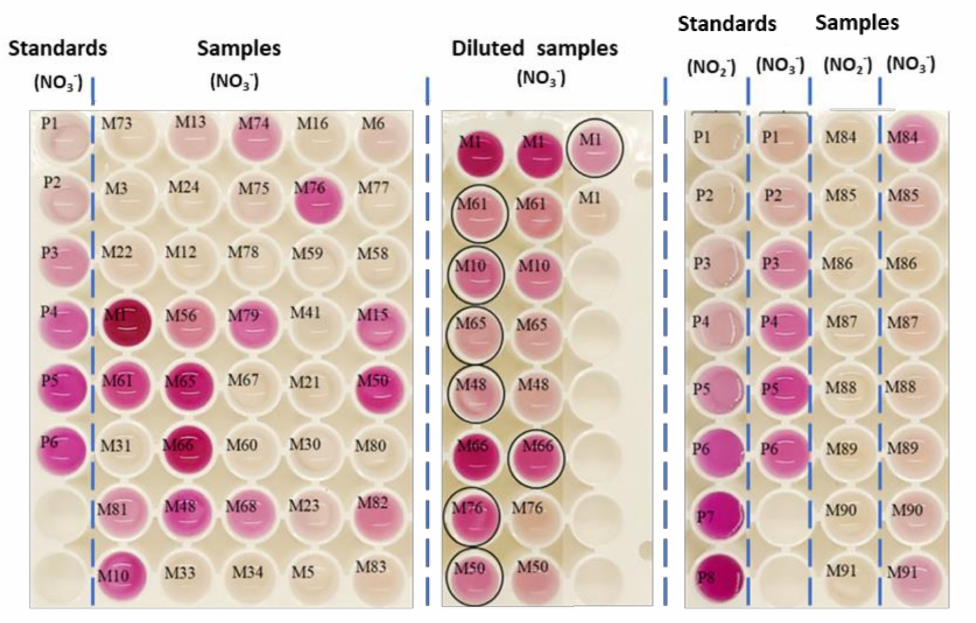
Figure 7. Calibration curve in 96-microplate of NO − to 25 mg L − 1 ) (P). Response to NO −